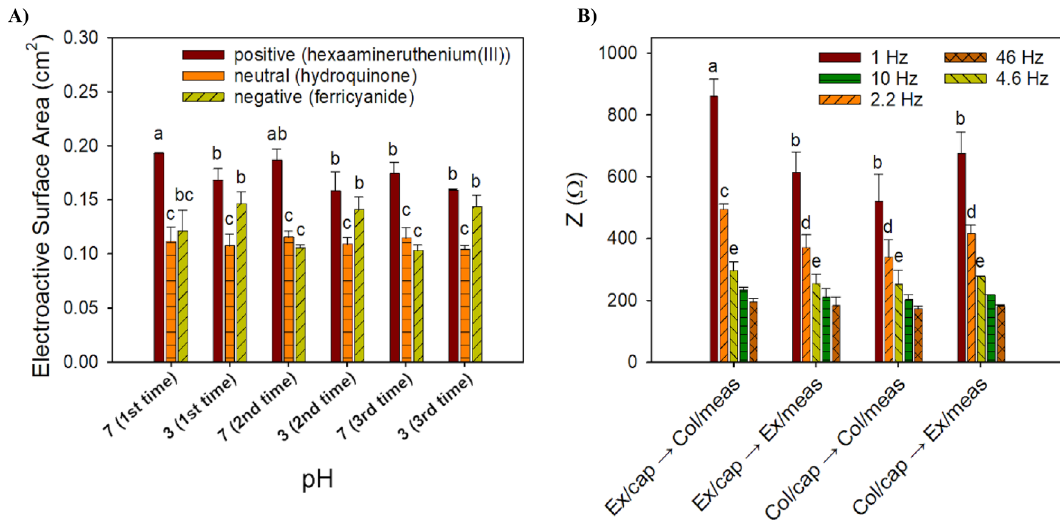
Figure 4. ( a ) Electrostatic interactions during three actuation cycles between pH 3 and pH 7 of the ALG- thiomer/Pt brushes with different redox probes: a positively charged probe (Ru(NH 3 ) 6 3+ , a negatively charged probe (KFeCN 6 3− ), and a neutral probe (C 6 H 4 (OH) 2 ). ( b ) Average total impedance for the ALG-thiomer/ Pt brush functionalized with 400 nM aptamer and exposed to 10 3 CFU mL −1 of Listeria monocytogenes at different cutoff frequencies for various capture/measure strategies based on actuation. “EX” refers to extended state (pH 7), “COL” refers to the collapsed brush state (pH 3), “cap” refers to cell capture and “meas” refers to measurement. Error bars denote the standard deviation of the arithmetic mean of at least three replicates; different letters represent significantly different means (p <